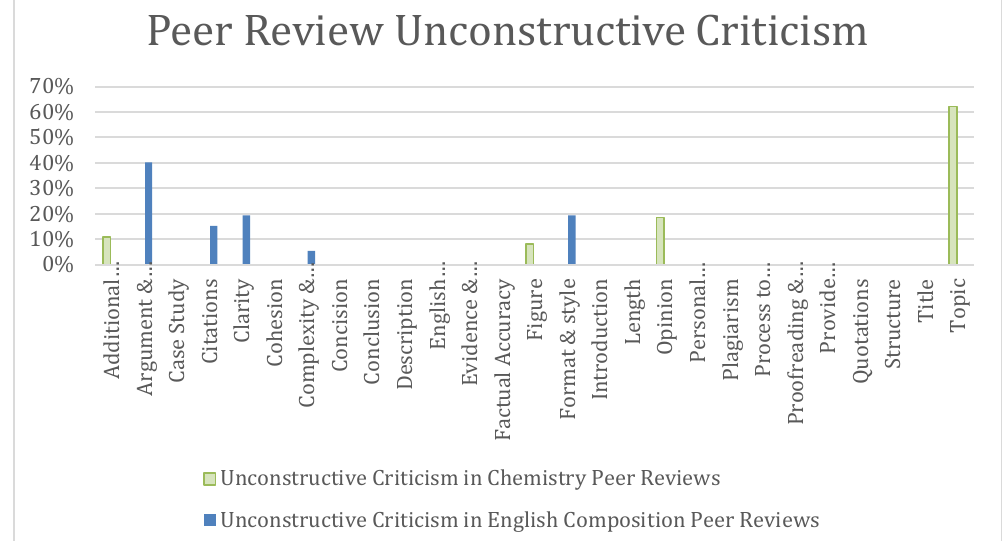
Figure 8. Unconstructive criticism writing elements in peer review open ended questions by course.